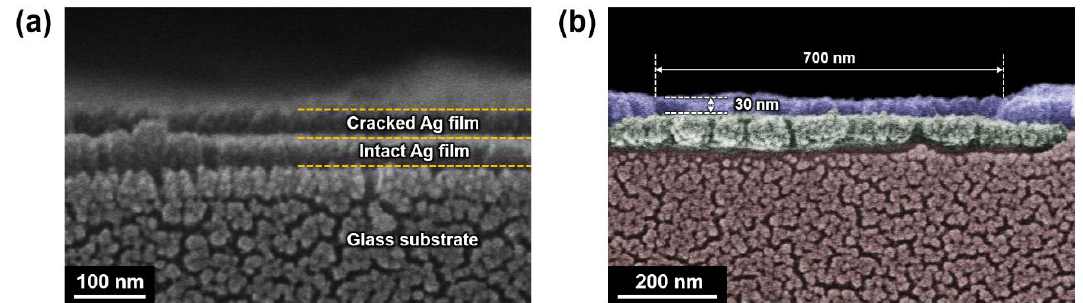
Figure 4. ( a ) SEM image of a selected cross section of the BA140 sample after completing the cold-welding process. ( b ) Colored SEM image of a selected cross section of the same sample as in ( a ). Red, green, and blue regions represent the glass substrate, the intact Ag film, and the cracked Ag film, respectively. The cross section of the crack (with 700 nm width and 30 nm depth) is clearly revealed in the blue region.